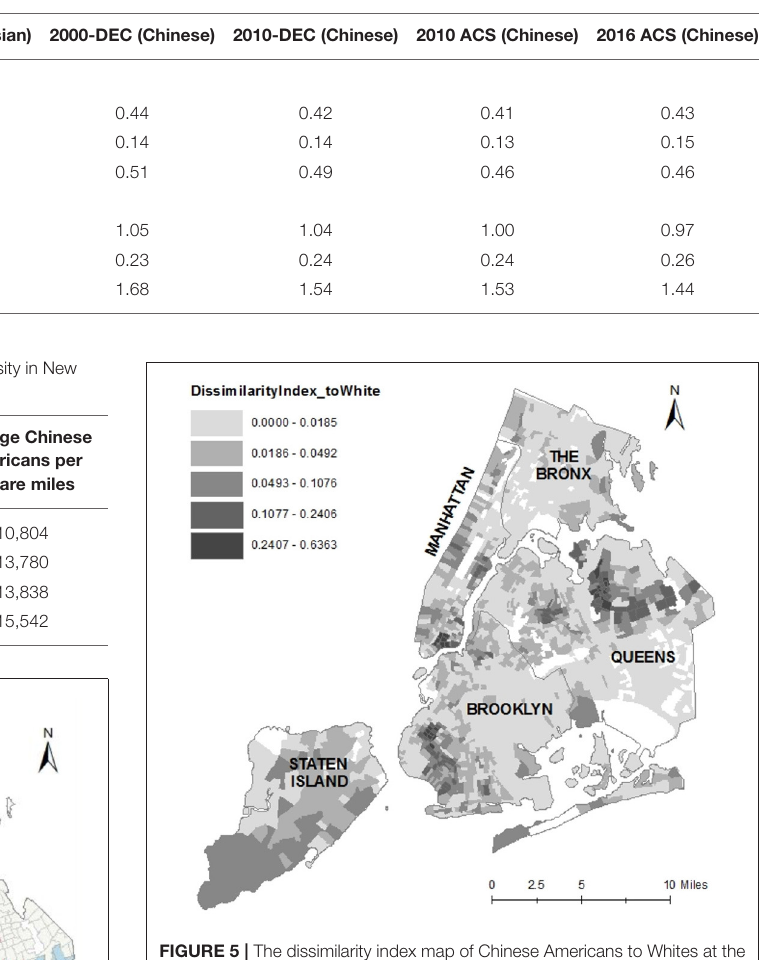
FIGURE 5 | The dissimilarity index map of Chinese Americans to Whites at the Census tract level, New York City.